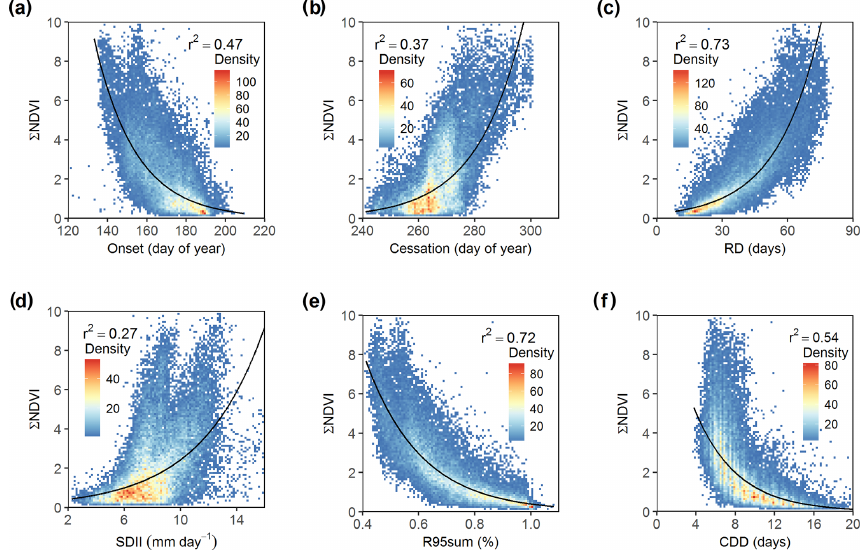
Figure 5. Density scatter plot showing the relationships between seasonal-rainfall metrics and growing season ANPP ( P NDVI). All analyses are based on 15-year averages (2001–2015). The black lines are exponential regression curves. All points ( n = 30862) are located between 100 and 800mm annual rainfall.